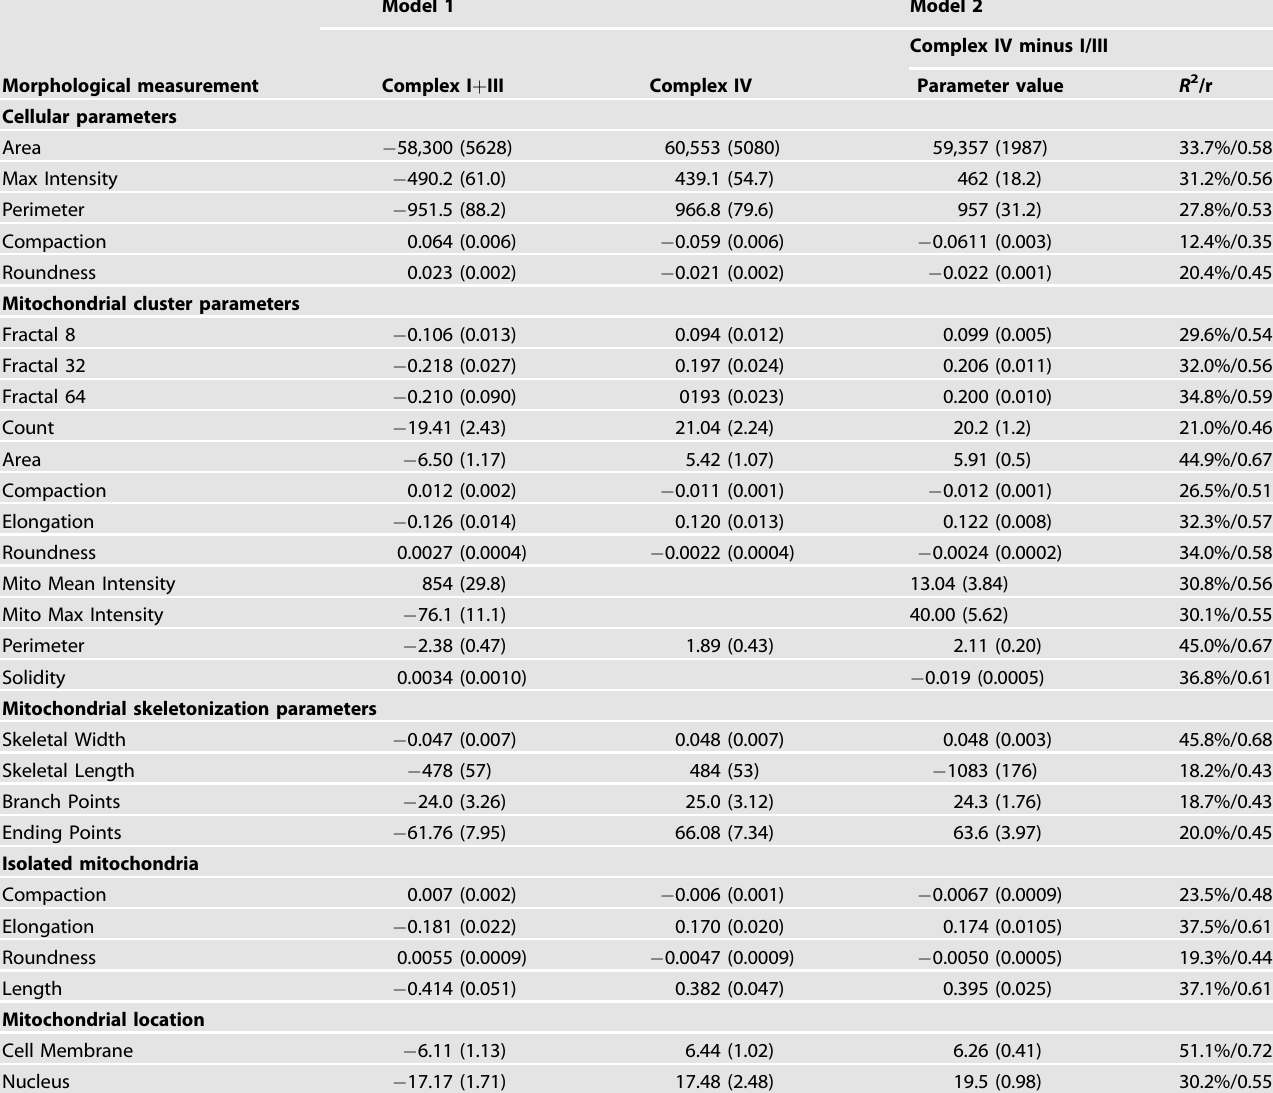
Table 5. Coef fi cients for two mixed-models [Mean (Standard Error)] examining the association between electron transport chain (ETC) complex activity and morphology in fi broblasts derived from children with autism spectrum disorder. R 2 and r values for model 2 are also depicted to provide a representation of the effect size of the